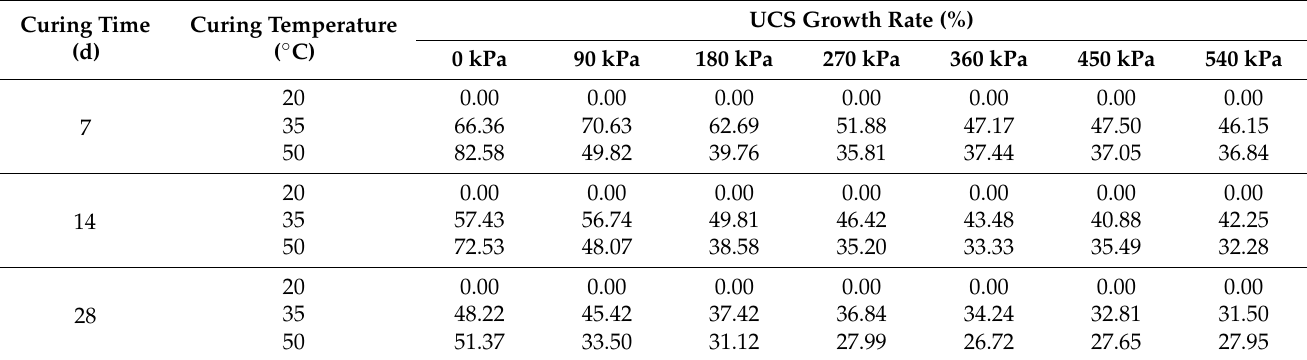
Table 3. The evolution rule of the UCS growth rate for the CPB.